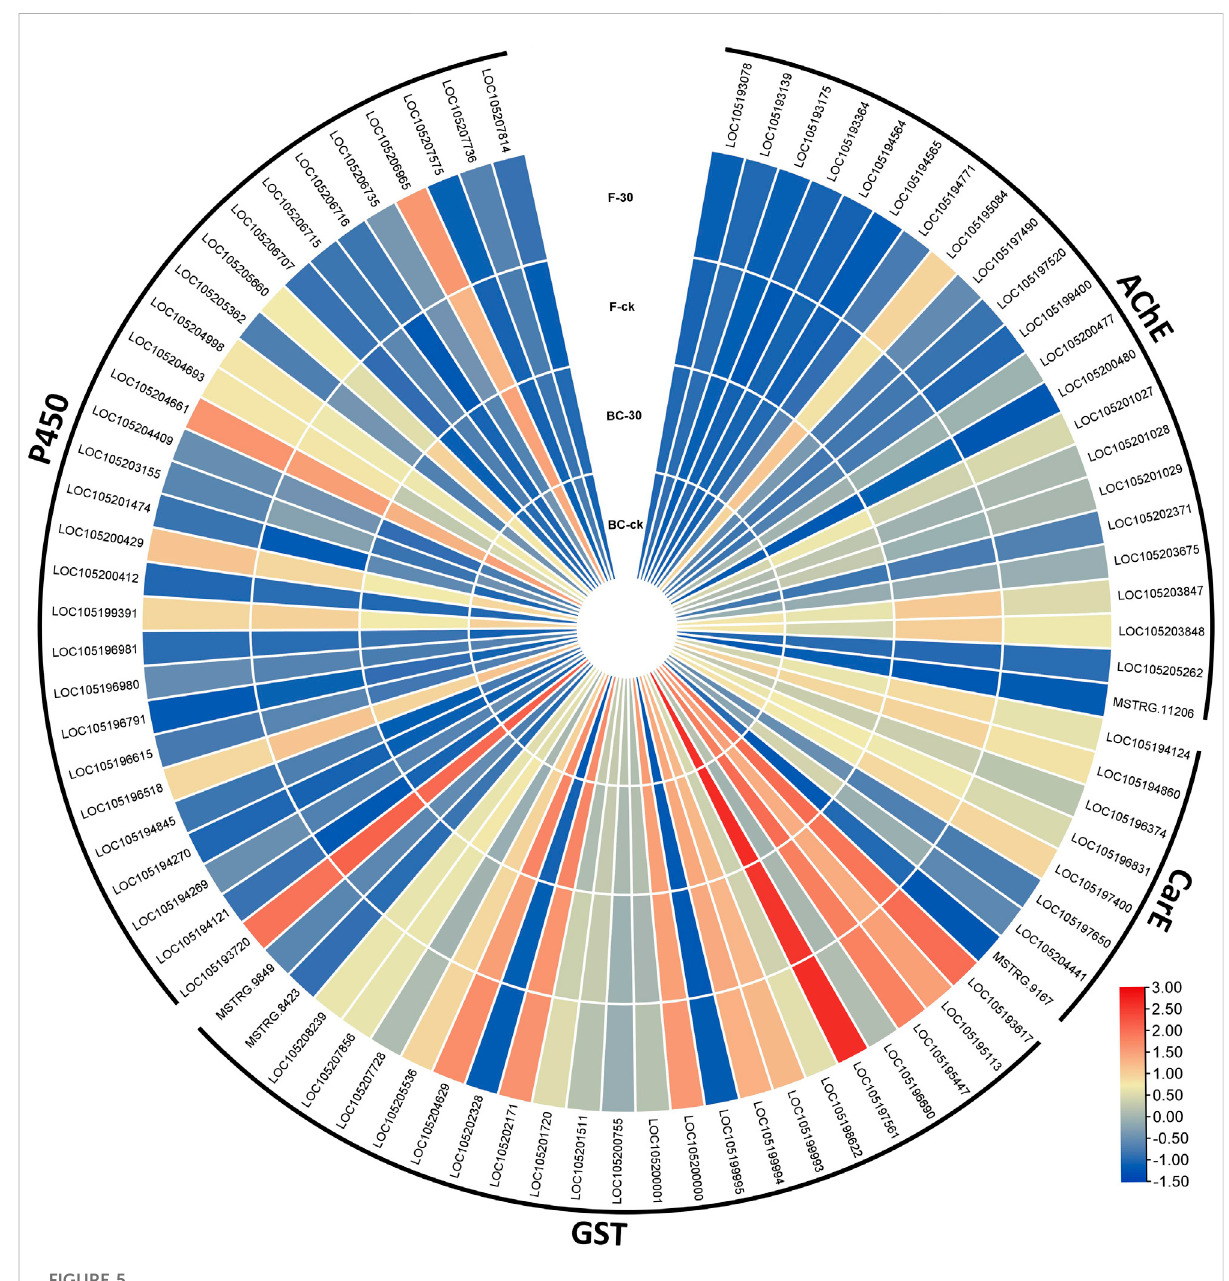
FIGURE 5 Comparison of signi fi cantly regulated insecticide detoxi fi cation genes in BC-ck vs. BC-30, F-ck vs. F-30 and BC-30 vs. F-30.